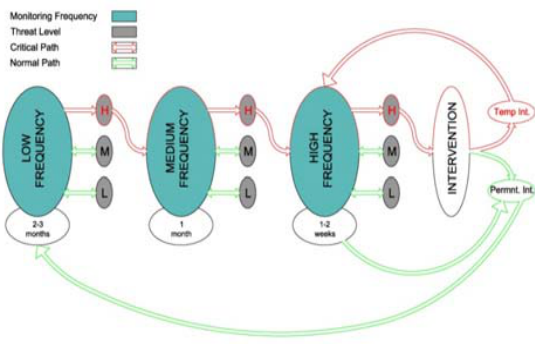
Figure 1. Monitoring